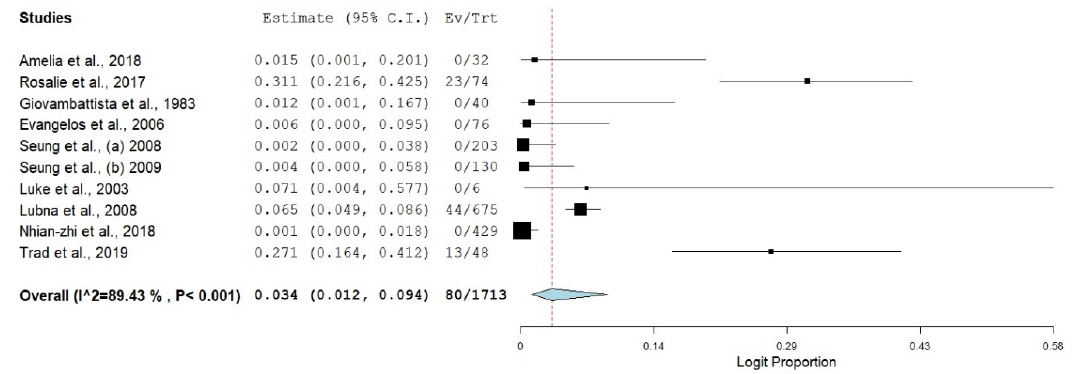
Table 2. Tau statistic and point estimate.